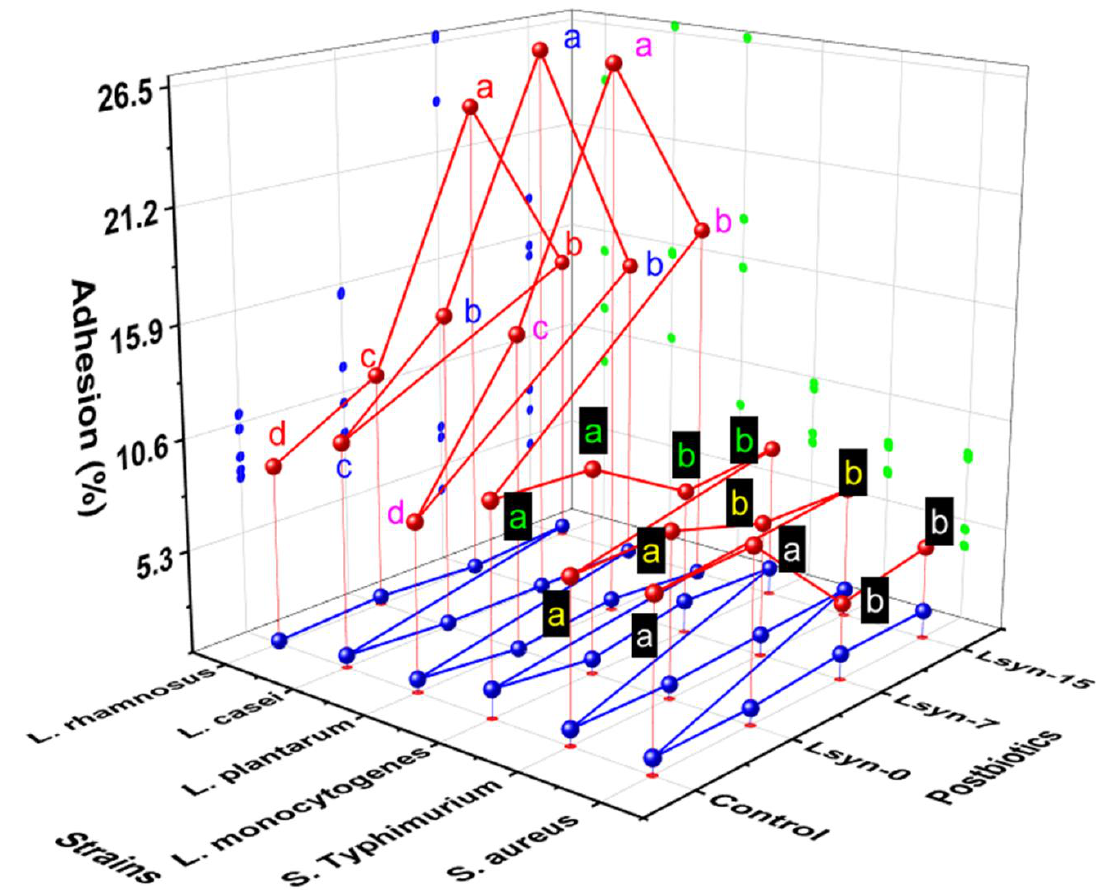
Figure 4. The influence of postbiotics (L syn − 0 , L syn − 7 and L syn − 15 ) on adherence ability (red sphere) of strains of foodborne pathogenic bacteria and probiotics to Caco-2 cells. Different letters indicate significant differences at p < 0.05. The blue sphere shows the standard division of the sample’s